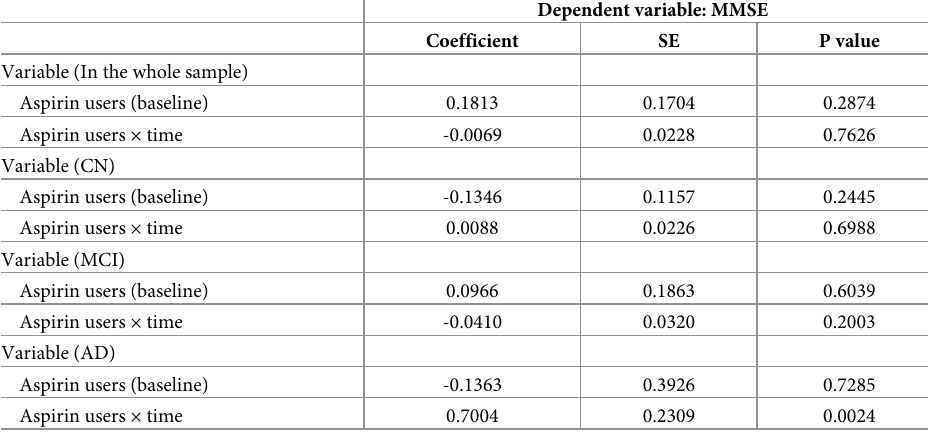
Table 3. Summary of linear mixed